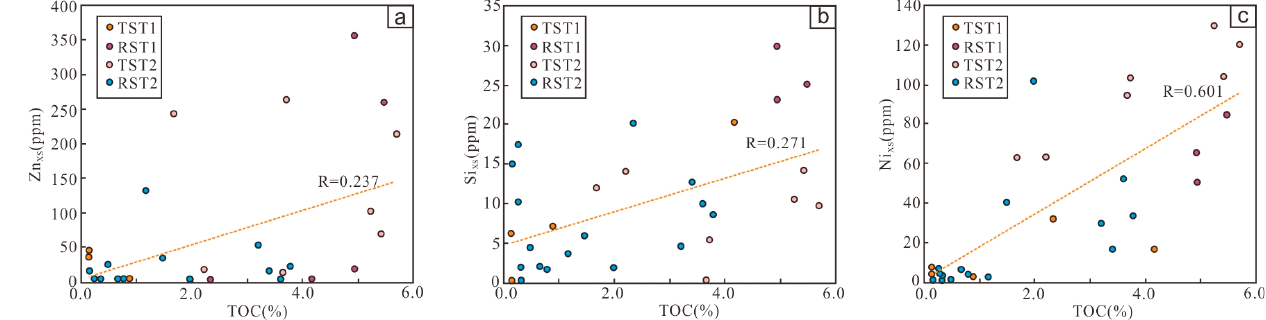
Figure 7. Crossplots of TOC vs. ( a ) Zn XS , ( b ) Si XS , and ( c ) Ni XS of samples from Well SY1.